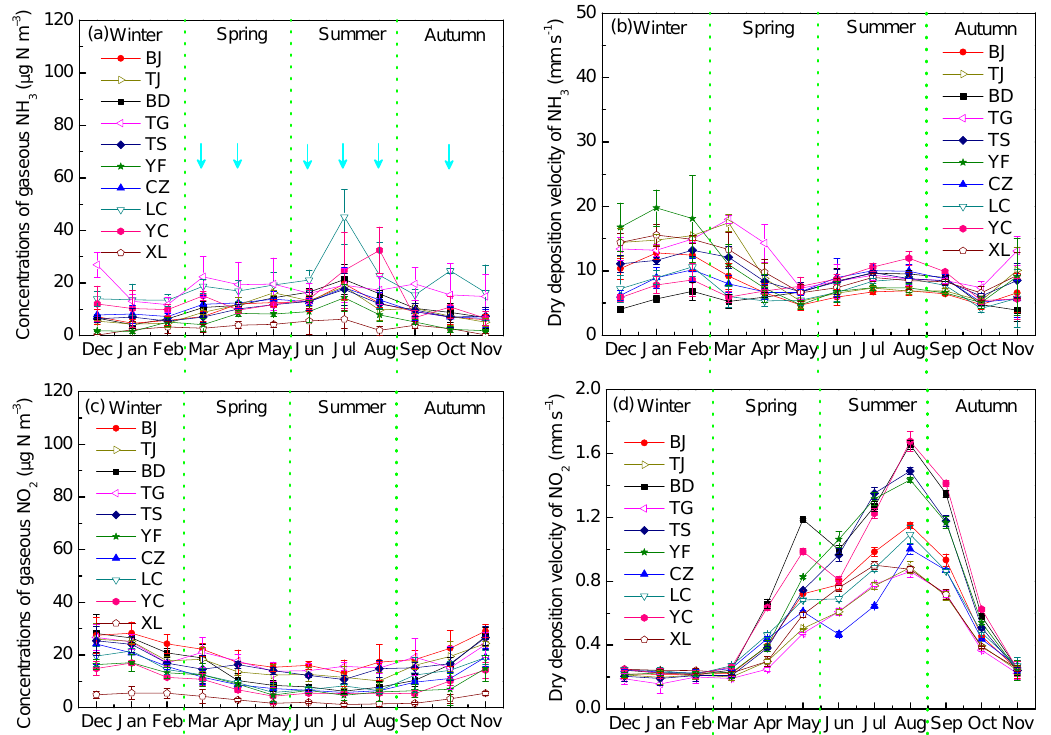
Fig. 5. Seasonal variations of the concentrations and dry deposition velocity of gaseous nitrogen species at the ten selected sites in Northern China. The data shown are the monthly mean ± standard deviations of three-year observations (from December 2007 to November 2010). The arrow denotes the timing of N fertilizer application for maize and wheat in agricultural regions of the YC and LC sites (a) . The definition of the site codes is found in the caption of Fig.